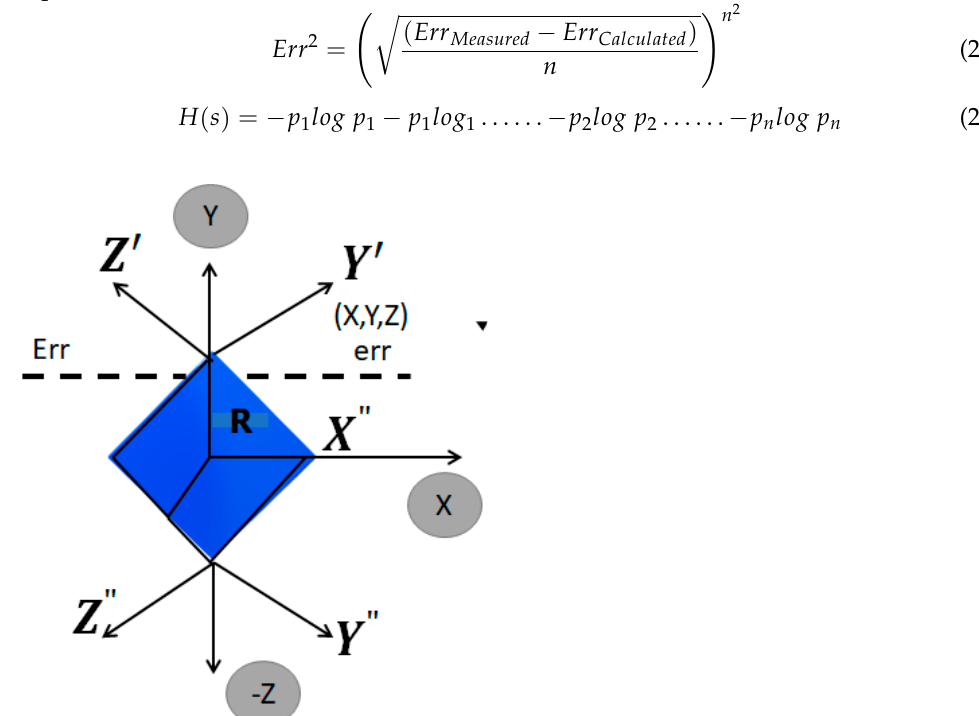
Figure 6. Logical illustration of complex error function in terms of LE and GE spread in each dimen- sion.